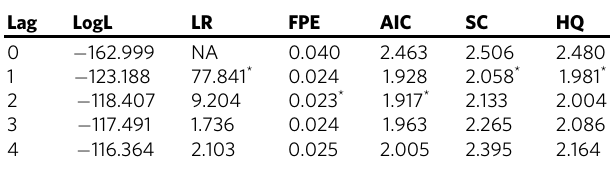
Table 2 The test of the optimal lag order.